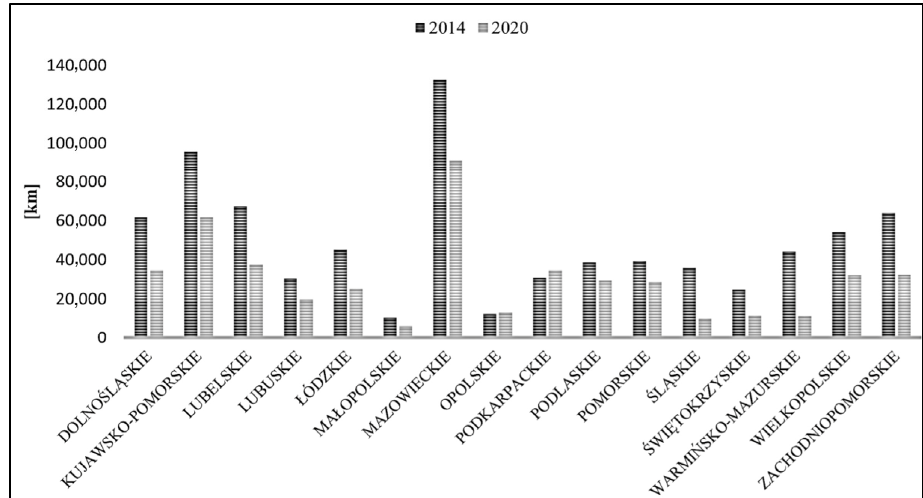
Figure 9. The length of regional bus lines broken down by voivodships in the years 2014–2020 in km (own study, based on [45]).